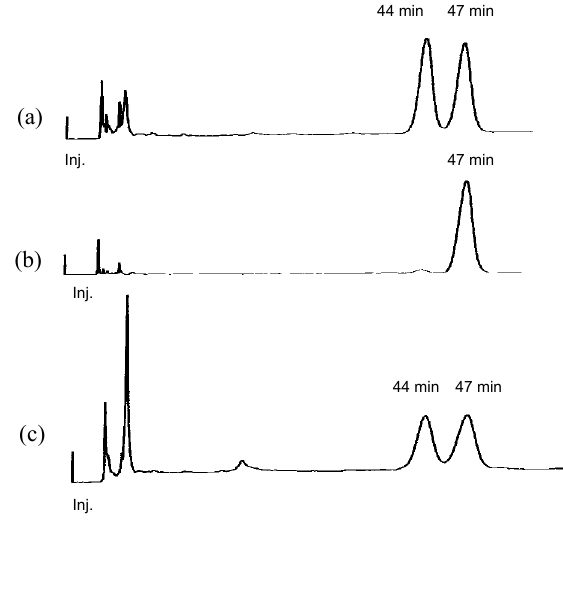
Figure 1. Chiral HPLC profiles of (a) synthetic compounds (±)- 2 , (b) (+)- 2 , and (c) pyrinodemin